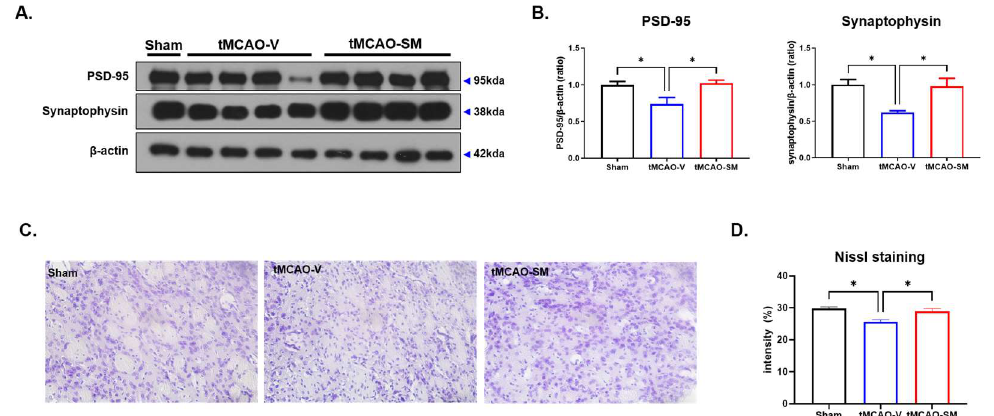
Figure 5. SM reduced synaptic loss and neuronal loss in tMCAO mouse brain. ( A ) Representative Western blots showing the expression of PSD-95 and Synaptophysin proteins in mice brains. ( B ) Quantification level of PSD-95 and synaptophysin proteins. β -actin was a loading control. (PSD-95, Sham, n = 4; tMCAO-V, n = 4; tMCAO-SM, n = 4; Synaptophysin, Sham, n = 4; tMCAO-V, n = 5; tMCAO-SM, n = 5). ( C ) Nissl staining in the penumbra area of the tMCAO mouse brain. Scale bar, 100 µm ( D ) Quantification for neuronal density in the striatum. (Sham, n = 3; tMCAO-V, n = 5; tMCAO-SM, n = 4). Statistical analysis between the three groups was performed by the one-way ANOVA following Tukey’s multiple comparisons test. * p < 0.05.